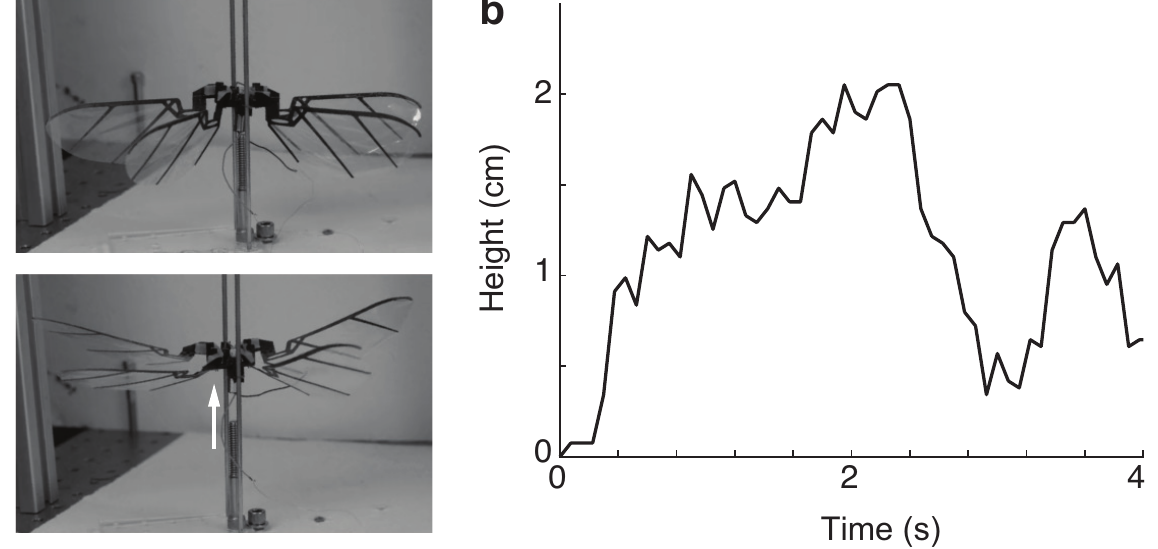
Figure 12. ( a ) Two frames from the supplemental movie, showing the robot’s lift-off on a tethered rail. ( b ) Height versus time during